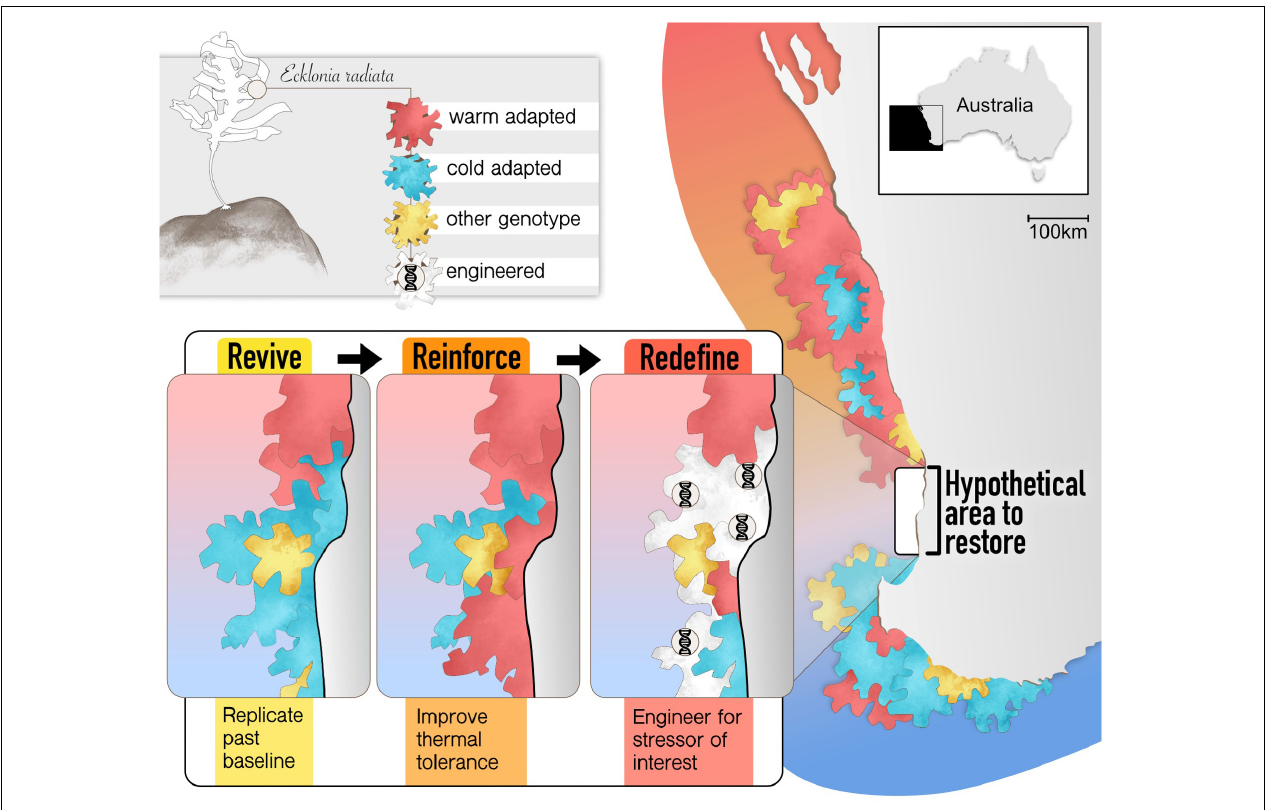
FIGURE 3 | Potential scenarios for kelp restoration for a hypothetical area to be restored off Western Australia. Frequencies of putative warm (red) and cool (blue) adapted genotypes have been identified along a gradient of ocean temperature (shaded background) which could be utilized to revive or reinforce kelp forests against future thermal stress. Kelps with engineered genetic elements could one day be used to redefine the genetic